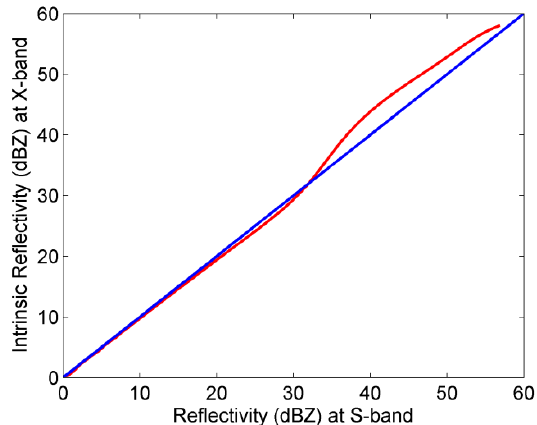
Figure 4. Scattering simulation of intrinsic reflectivity at X and S bands. The blue line stands for the intrinsic reflectivity at X-band is equal to the reflectivity at S-band. The red curve is obtained by scattering simulation.